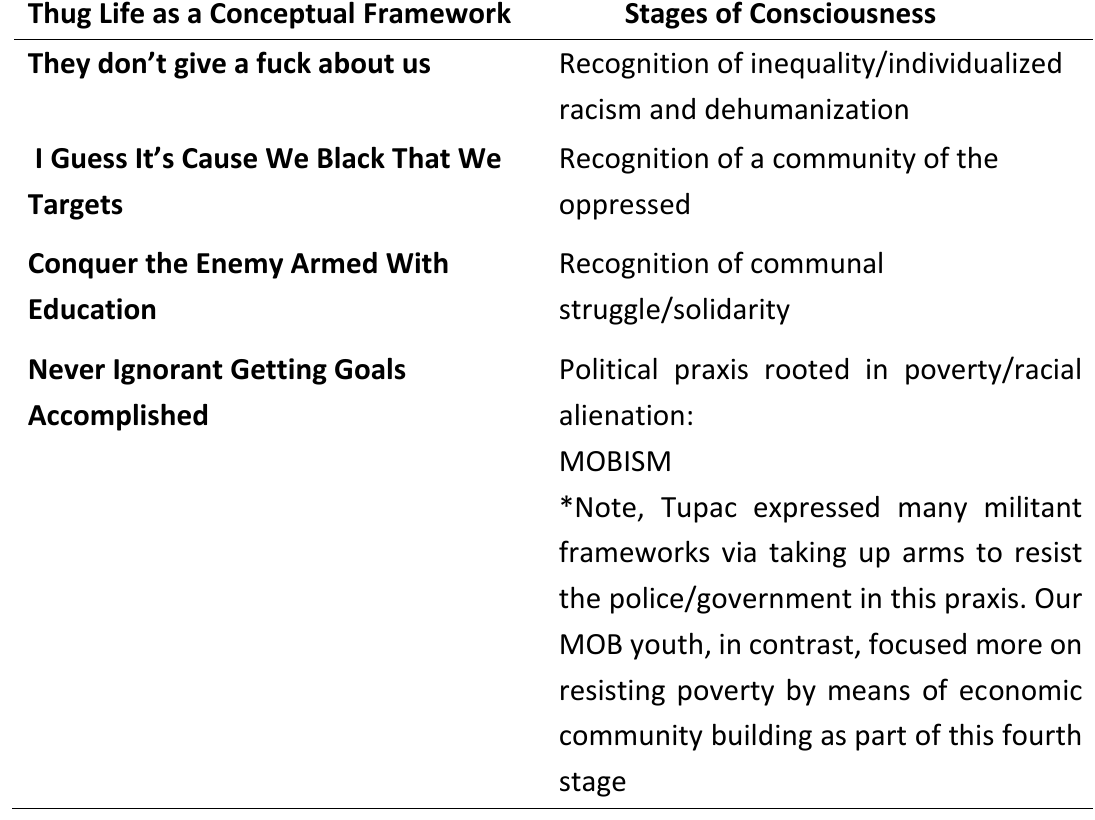
Table 1. Thug Life as a Conceptual Framework Thug Life as a Conceptual Framework Stages of